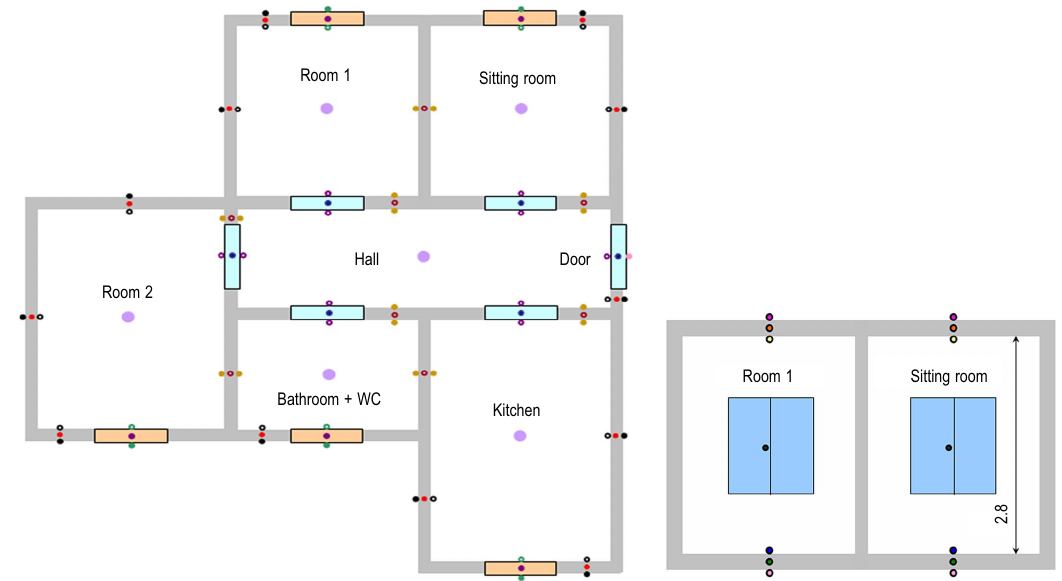
Fig. 3. Descriptive plane: